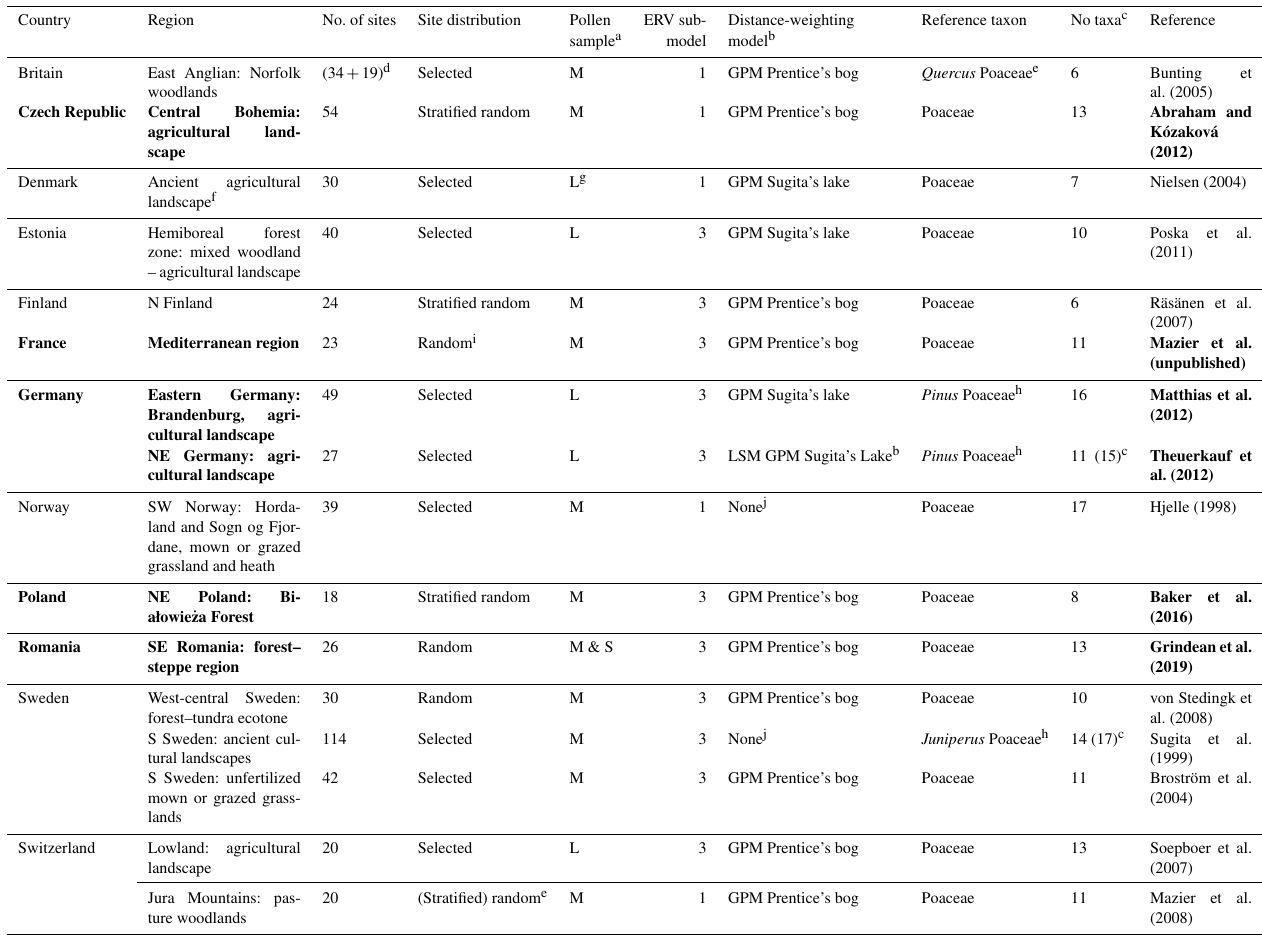
Table C1. Selection of studies for the synthesis of relative pollen productivity (RPP) estimates. Emphasized in bold: additional, new stud- ies compared to the studies included in the synthesis of Mazier et al. (2012). a L: lakes; M: moss pollsters; S: surface soil. b Different distance-weighting models were used depending on the study, including the Gaussian plume model (GPM), 1 /d , 1 /d 2 ( d = distance) and the Lagrangian stochastic model (LSM). The GPM is used in the model developed for both bogs (Parsons and Prentice, 1981; Prentice and Parsons, 1983) and lakes (Sugita, 1993). For this RPP synthesis, we chose the results from the analyses using GPM rather than 1 /d or 1 /d 2 . Note: in the study of Theuerkauf et al. (2012) the LSM was used. For this synthesis, Theuerkauf recalculated his RPPs using the lake model developed by Sugita (1993). c Number of plant taxa for which RPP was estimated, including the reference taxon. Note: in the study by Theuerkauf et al. (2012) RPPs were estimated for 17 taxa using the LSM. The RPPs were recalculated using the lake model (Sugita, 1993) for 15 taxa (see note under b above) for this synthesis. In the study of Sugita et al. (1999) RPPs were calculated for 14 trees and 3 herbs. We used only the values for the 14 trees in this synthesis, following the syntheses by Broström et al. (2008) and Mazier et al. (2012). d Britain: the study includes two areas in which RPP estimates were calculated for different sets of taxa, and the two areas have different numbers of sites (Calthorpe (34), five taxa; Wheatfen (19), same five taxa and Corylus (six taxa in total). e The study of Bunting et al. (2005) does